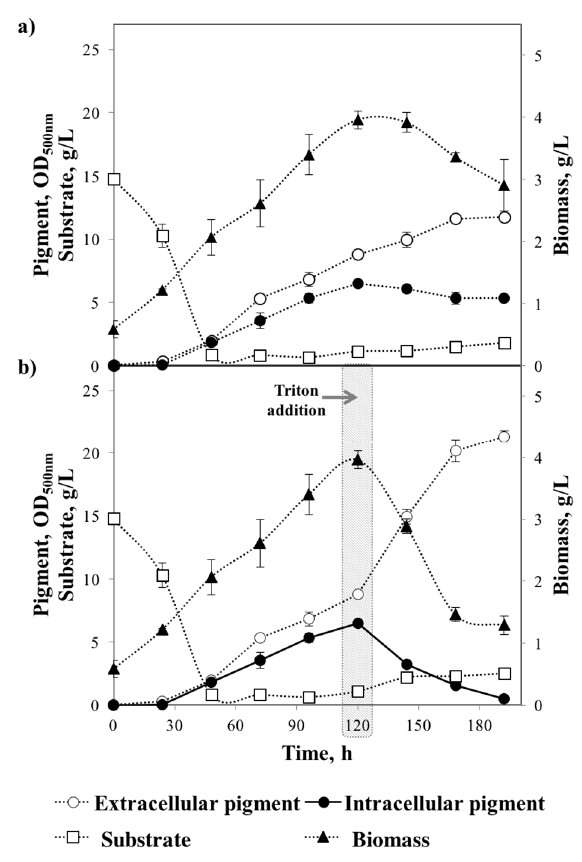
Figure 3. Kinetics of extracellular and intracellular pigment production, substrate consumption and biomass growth. ( a ) Without surfactant; ( b ) Triton X-100 added at 120 h of fermentation.